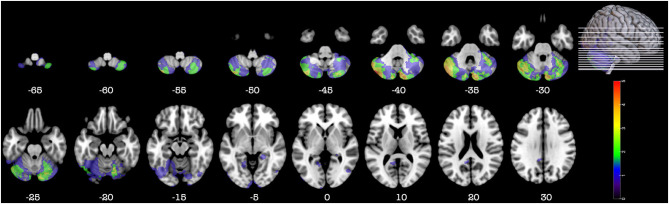
Representative axial slices depicting the lesion overlay density maps of TBI participants in the sub-group of cerebellar participants with a large cerebellar lesion (>15%) but a small lesion (<15%) in other part of the brain (n = 9). Z-values shown at the bottom of each slice indicate the z coordinates (MNI) of each axial slice represented in the 3D view of the brain by white line. The color indicates the number of veterans in the group with damage to a given voxel. Images are in radiological space (i.e., right is left).